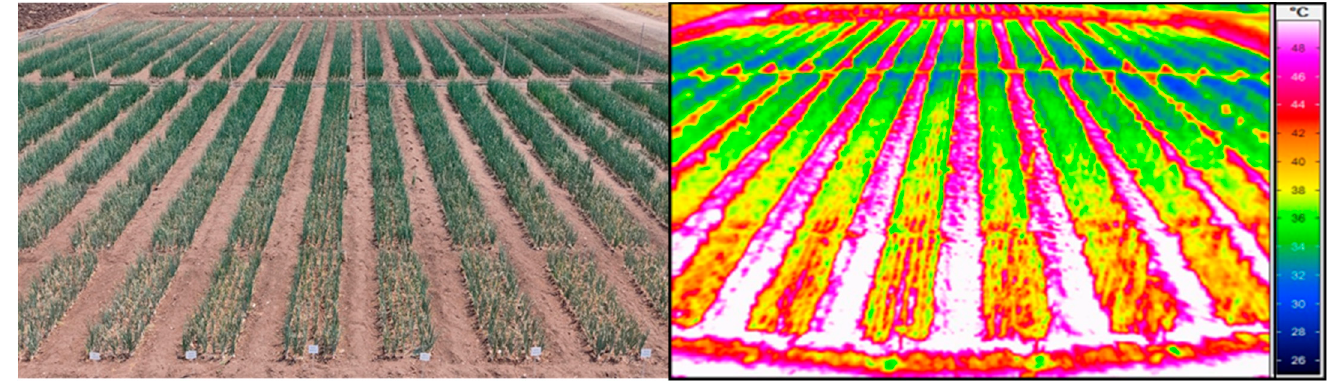
Figure 1. Visible image ( Left ) and thermal image ( Right ) of the line source sprinkler experimental set-up in the field.